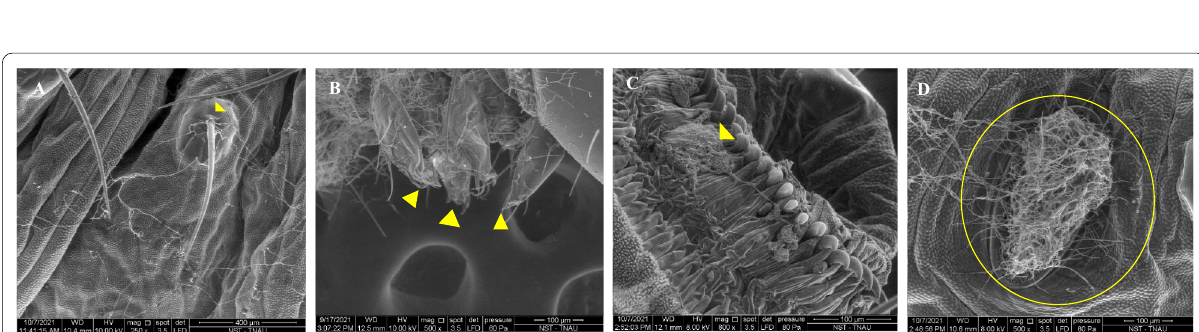
Fig. 7 SEM images of second instar of Spodoptera frugiperda infected with Metarhizium anisopliae (120 hpi). a . Extrusion of mycelium from setal socket (arrowhead). b . Mycelia growth over thoracic legs (arrowheads). c . Anal prolegs with hyphal clusters (arrowhead). d . Close-up of abdominal spiracular region with hyphal clusters